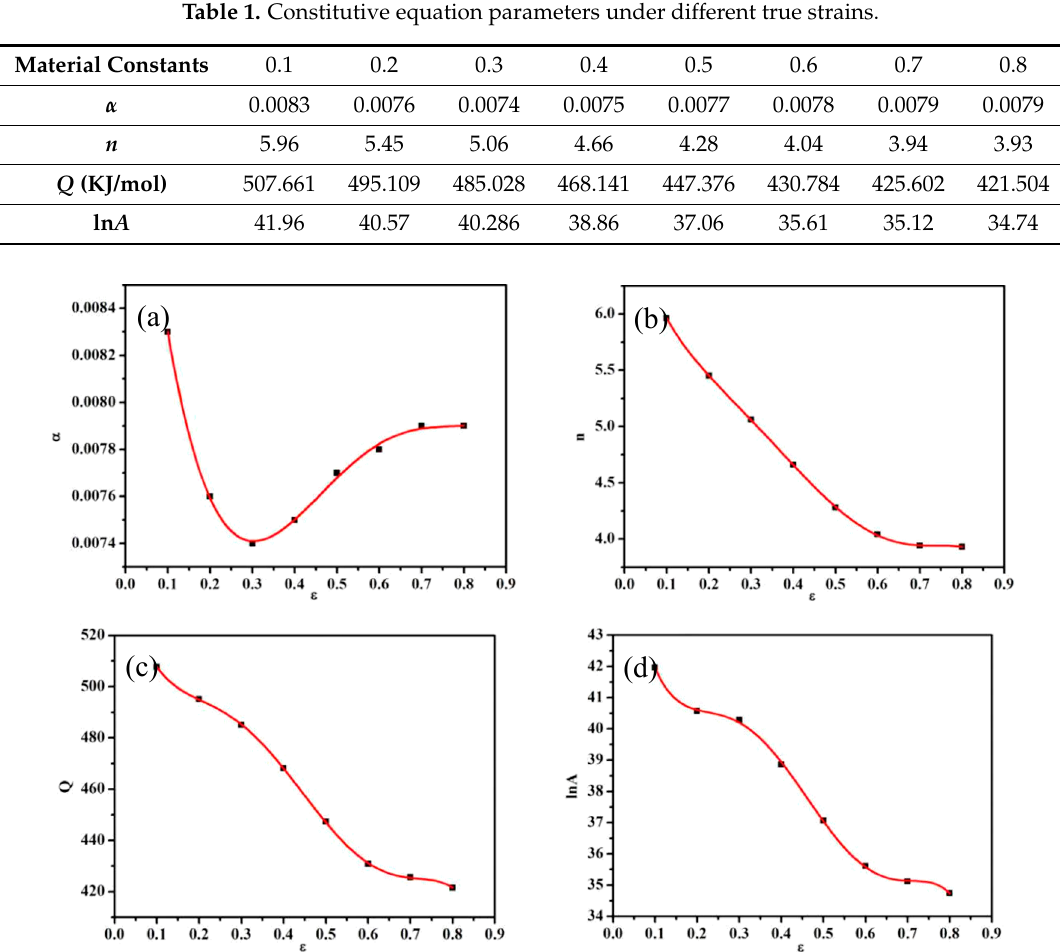
Figure 4. The relationship between equation parameters and true strain: ( a ) α , ( b ) n , ( c ) Q , ( d ) ln A .